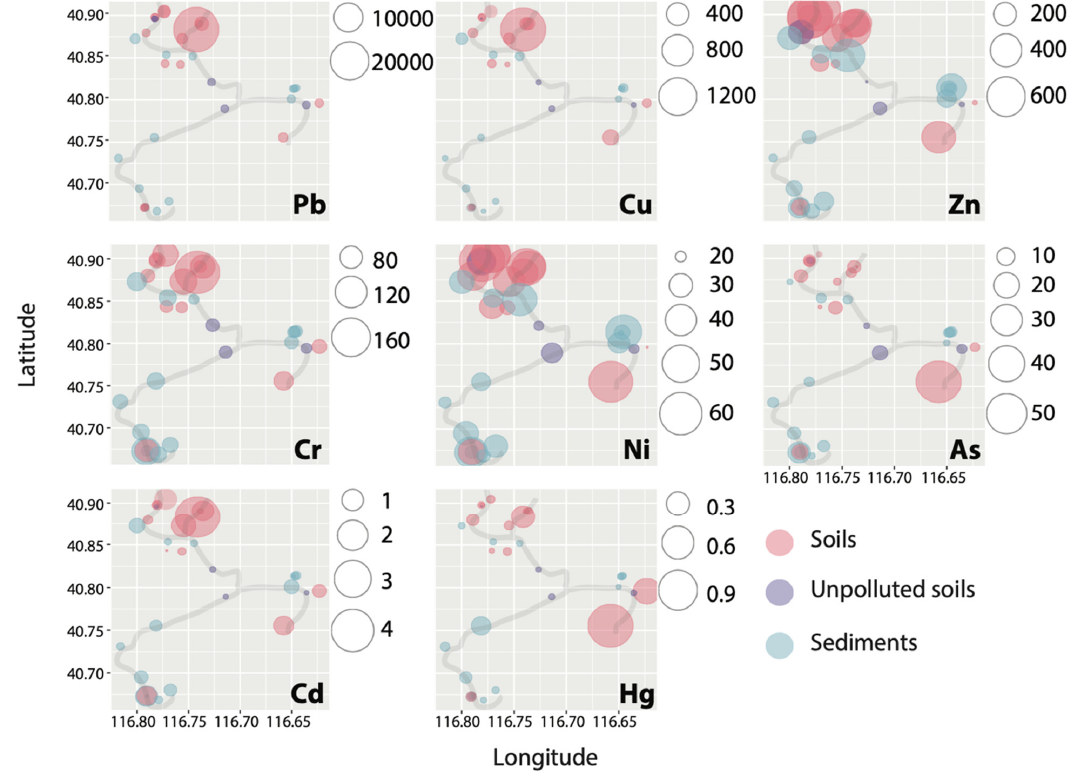
Figure 2. Spatial distribution of PTE contents (mg/kg) in soils and sediments.